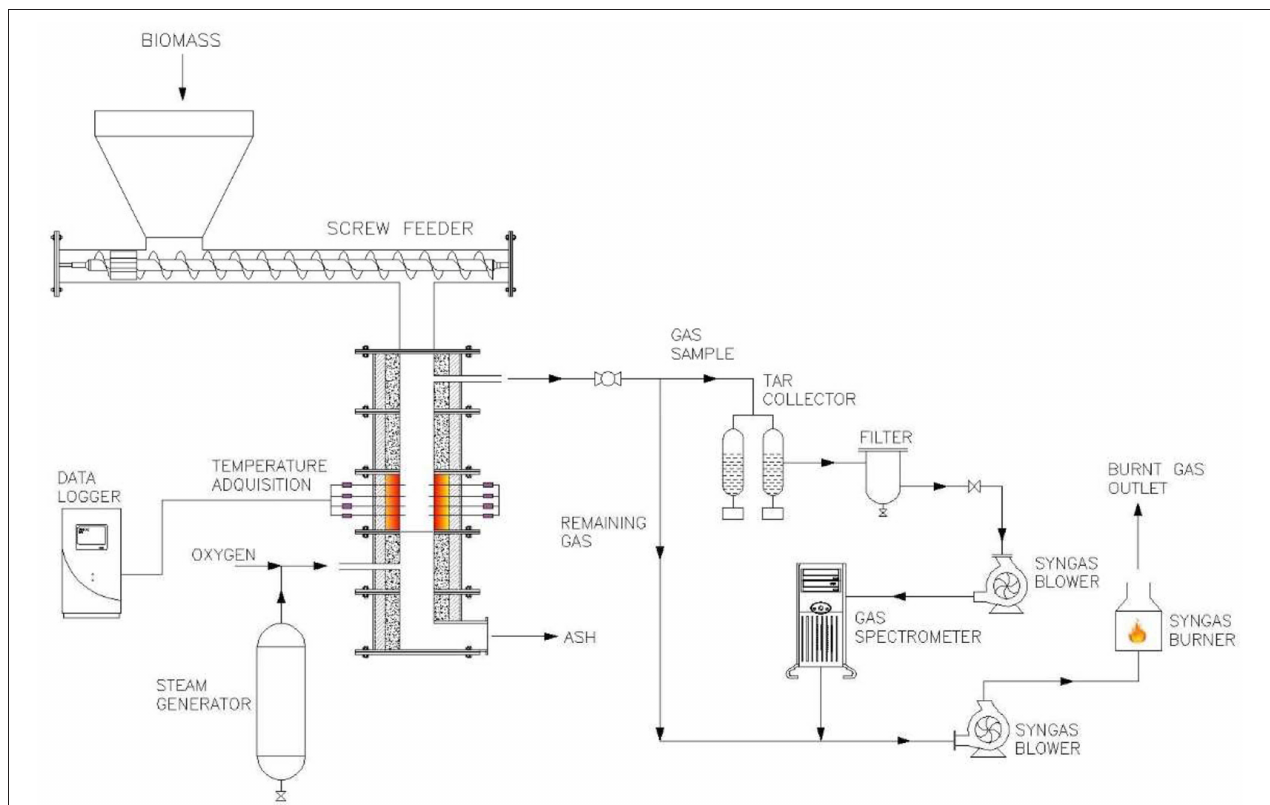
FIGURE 1 | Gasification facility.